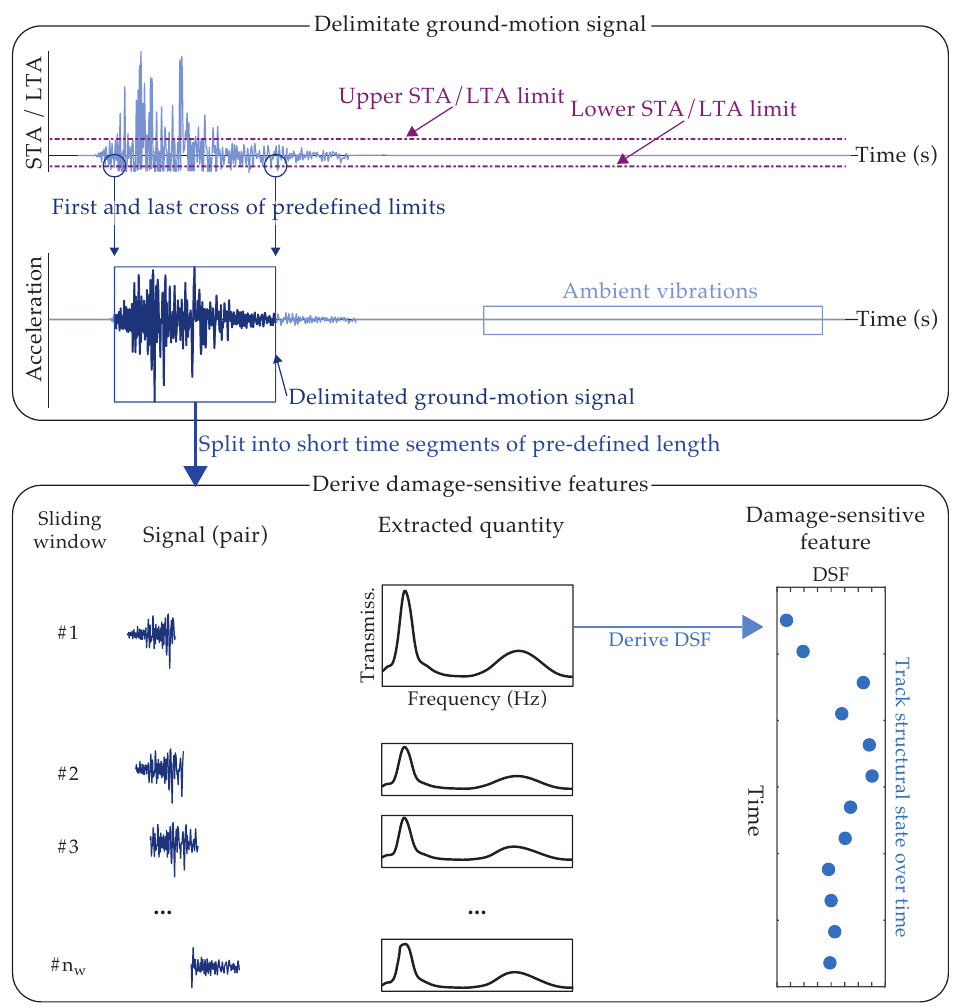
Figure 2. Extraction of damage indicators from vibration-based monitoring data. A triggering algorithm based on the ratio between short-time average and long-time average (STA/LTA) is used to frame the GM signal, which is then decomposed into shorter windows for computation of the associated